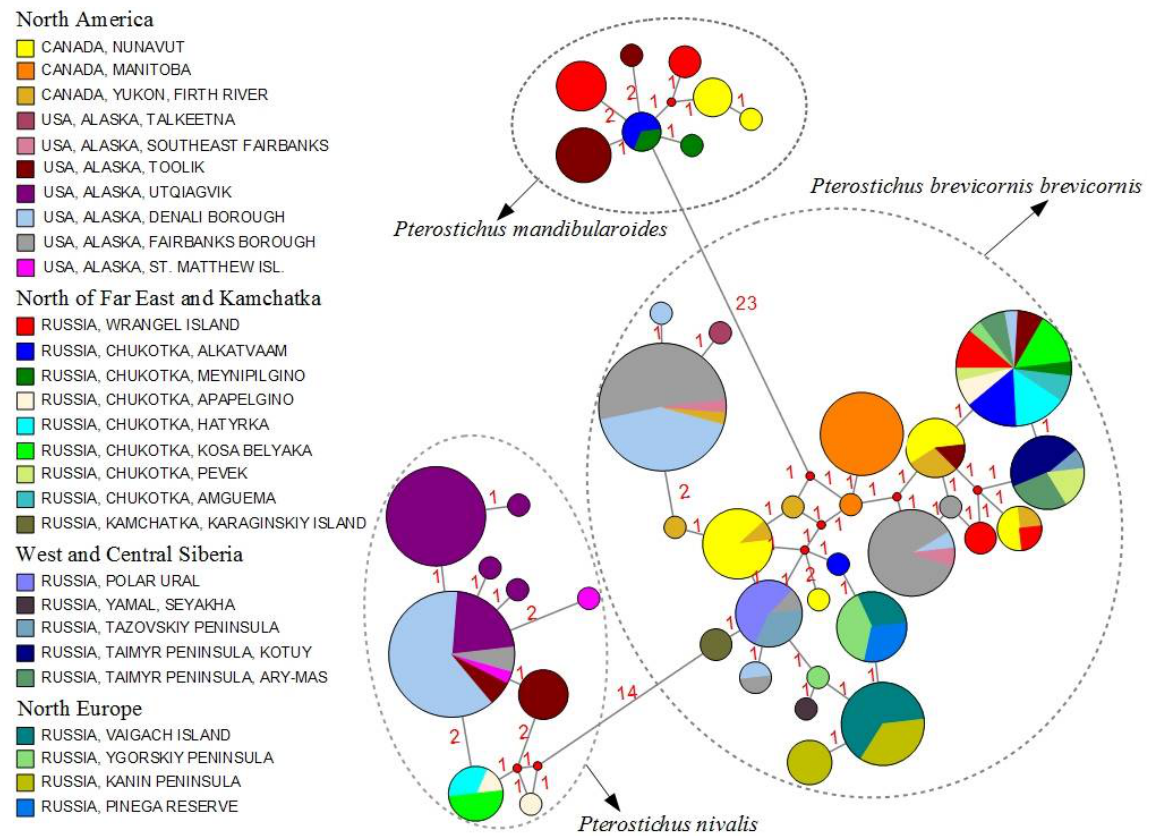
Figure 3. Phylogeography of P. mandibularoides , P. b. brevicornis , and P.nivalis . Median-joining network of COI sequences (see Table S1).